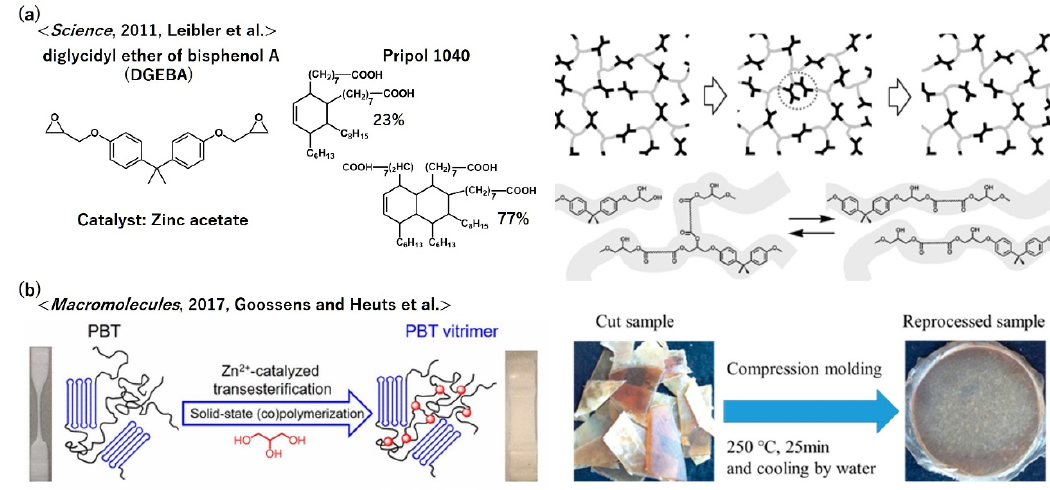
Figure 8. Examples of vitrimer polyesters according to ( a ) ref. [23] and ( b ) ref. [43]. ( a ) From (Montarnal, D.; Capelot, M.; Tournilhac, F.; Leibler, L., Science 334 (6058), 965–968, (2011)). Adapted with permission from AAAS. ( b ) Reprinted with permission from ref. [43]. Copyright (2017) American Chemical Society.